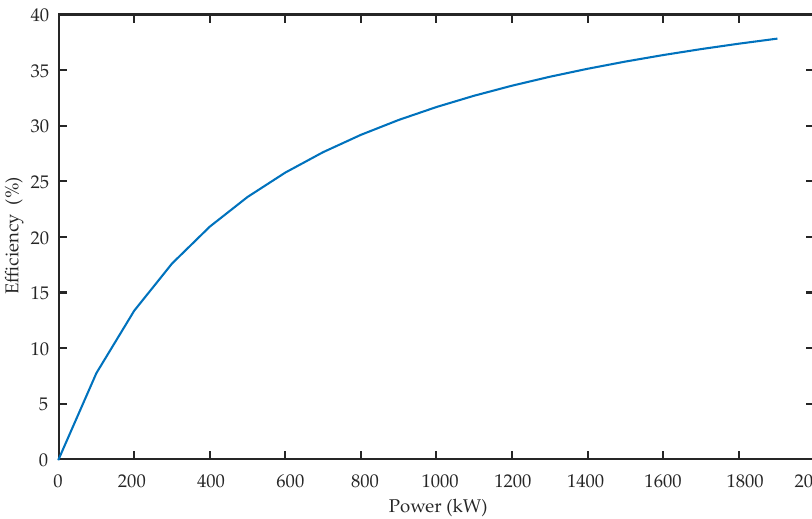
Figure 5. Efficiency curve for the 1850 kW diesel generators used in